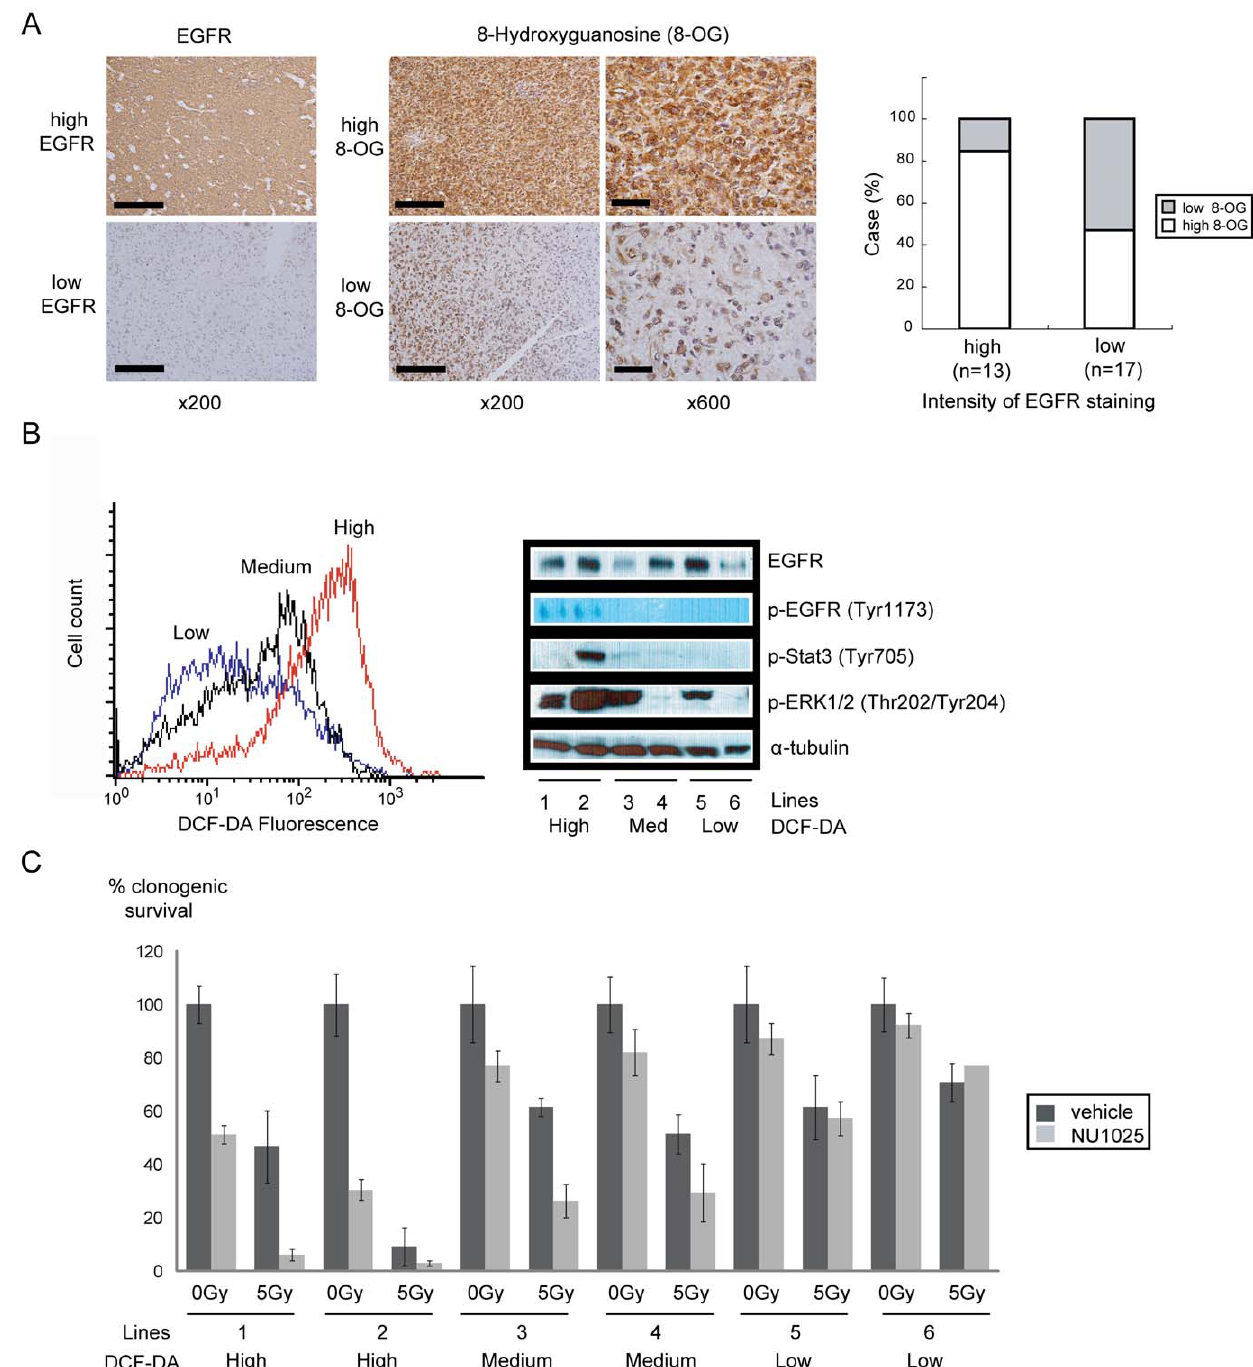
Figure 3. Clinical correlation between EGFR expression, oxidative stress and sensitivity to PARP inhibition. (A) EGFR expression correlated with 8-hydroxyguanosine (8-OG) staining in a glioblastoma microarray. Glioblastomas were stratified into high or low EGFR staining groups. Within each group, the percent of cases with high 8-OG staining is shown in white; low 8-OG staining in gray (right). Representative pictures of high and low staining patterns of EGFR and 8-OG are shown (left). Scale bar, 200 mm ( 6 200), 50 mm ( 6 600). (B) Correlation between DCF-DA fluorescence and EGFR. Primary glioblastoma lines were grouped based on DCF-DA staining (left). p-EGFR, p-Stat3, and p-ERK1/2 levels were assessed (right). (C) the level of oxidative stress/EGFR activation correlated with sensitivity to PARP1 inhibition.